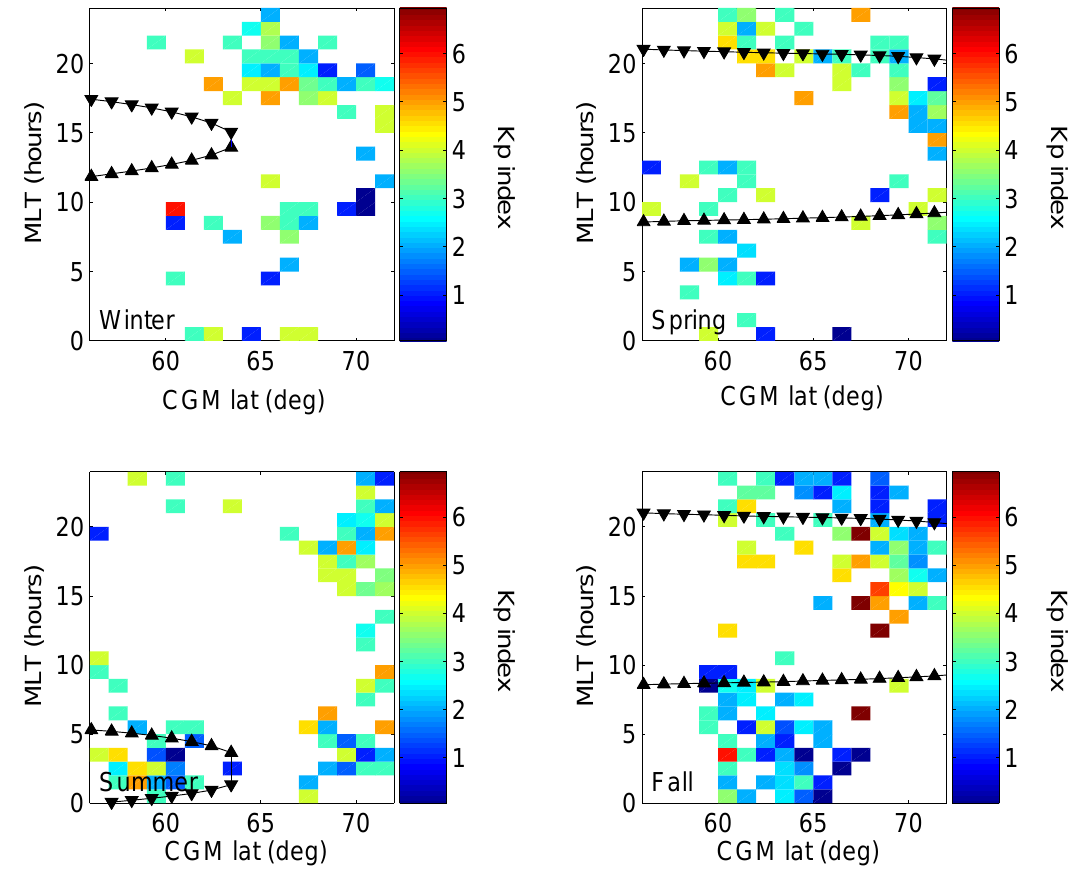
Fig. 3. Same as Fig. 2 for the observations of the poleward edges of the troughs observed in 2003. solstices is also shown here, with triangles pointing towards the